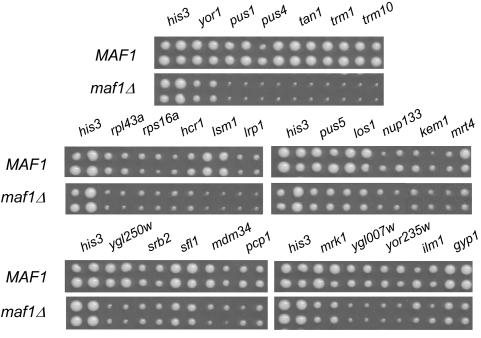
Genetic interactions between MAF1 and non-essential gene deletions.Representative viable gene-deletion strains (G418-resistant) that were confirmed by random spore analysis as having fitness defects with maf1Δ were arrayed in quadruplicate and crossed to clonNat-resistant MAF1 (Y5518) and maf1Δ (Y6338) query strains to compare the growth of haploid double-drug resistant strains following the standard SGA protocol [15]. The final double-drug containing plates were incubated at 30°C. A his3Δ strain was included as a negative control (i.e. no interaction with the maf1Δ strain).